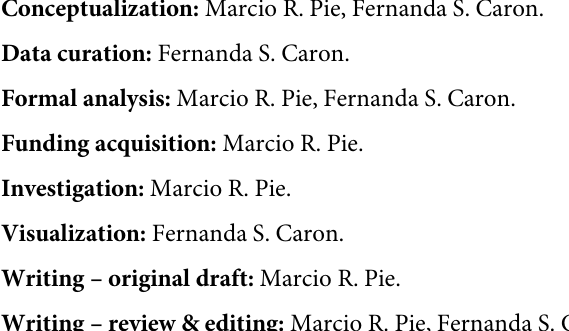
Highlands (CDH) (N = 278 species), Central Andes (CAN) (N = 801 species), Northern Andes (NAN) (N = 768 species), and Tepuis (TEP) (N = 142 species): (A) altitudinal distribution of the species in each location, ranked according to the lowest limit to facilitate visualization; (B) altitudinal range size distribution; (C) altitudinal range overlap distribution (gray histogram indicates the expectation of the range overlap distribution based on 100 model simulations using mean and standard deviation calculated directly from the empirical data, and the colored and gray vertical lines indicate the observed and simulated mean range overlap, respectively); (D) distribution of the simulated number (n = 100) of overlapping species (histogram) and the observed means for each location (vertical lines); (E) degree distribution across nodes in the empirical datasets (colored lines) and expectations based on simulations (n = 50) (gray lines); (F) betweenness across nodes in the empirical datasets (colored lines) and expectations based on simulations (n = 50) (gray lines); (G) closeness across nodes in the empirical datasets (col- ored lines) and expectations based on simulations (n = 50) (gray